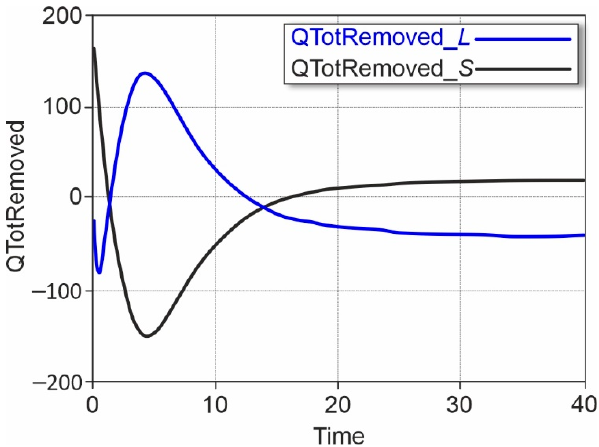
Figure 10. Change in the coefficient of heat exchange in the system loop and in the feedback line at the output of the compressor model in time: QTotRemoved_ S —change in heat flow in the system circuit; QTotRemoved_ L —change in heat flow in the feedback line.